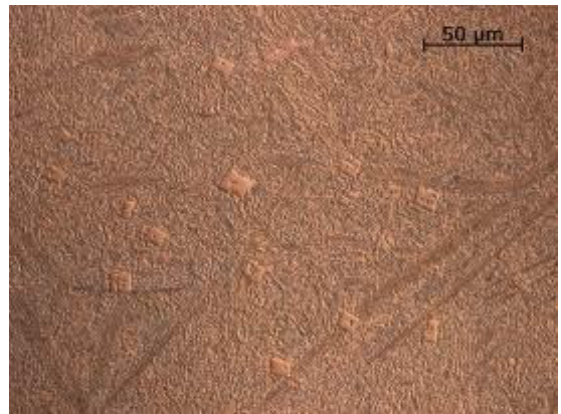
Figure 9. Microstructure of a nanocrystalline layer with carbide precipitates of NANO (Fe-Cr-Nb-B). SEM analysis showed that the observed carbide precipitates which appeared larger in size were niobium and chromium carbides, shown in Figures 10 and 11.